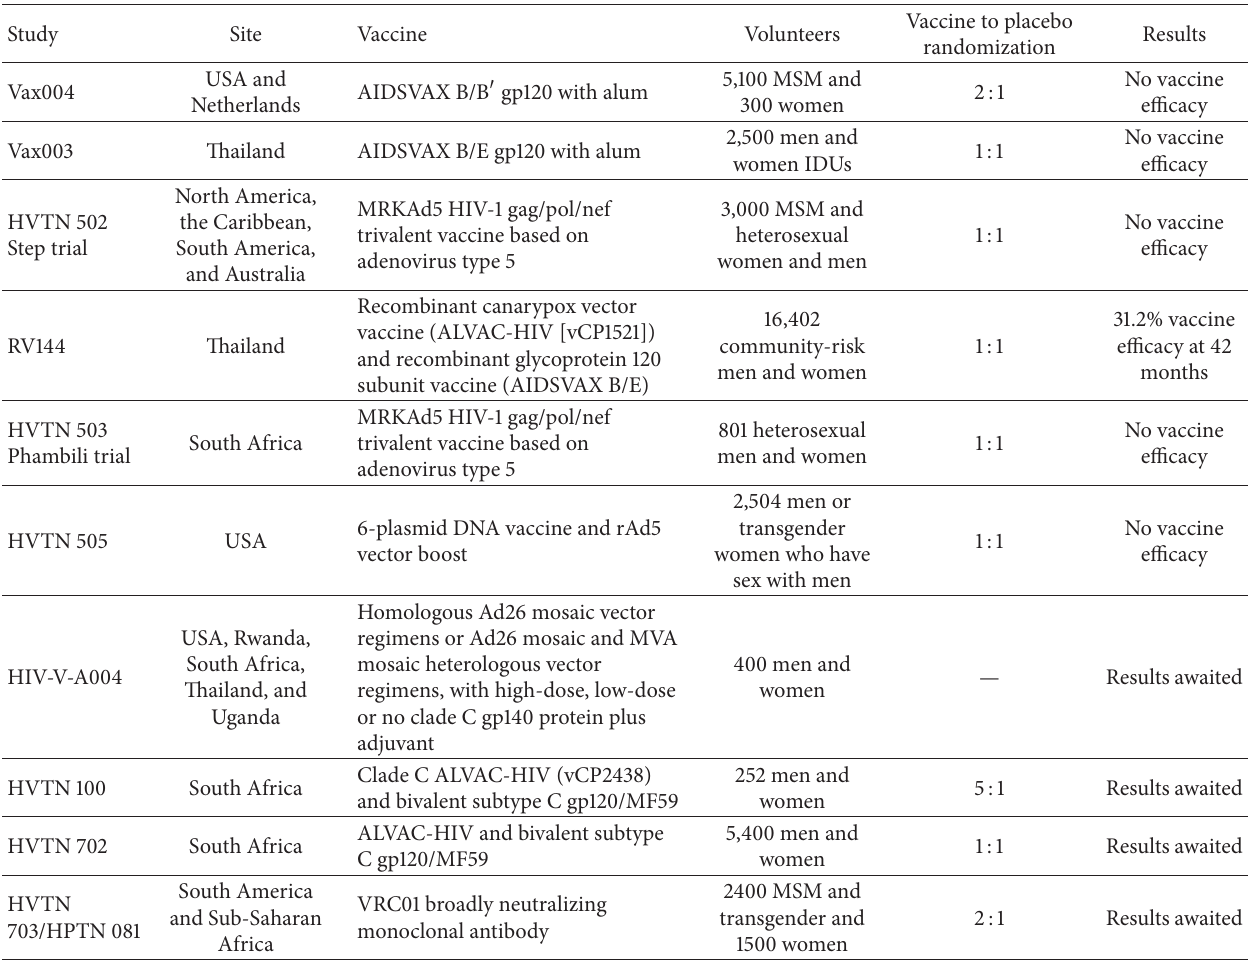
Table 1: HIV vaccine efficacy